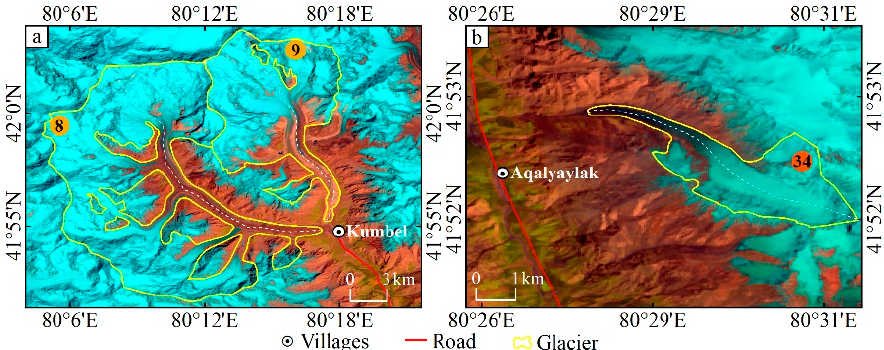
Figure 15. The surge phase ( a ), quiescent phase ( b ) and the time of surge ( c ) in different regions of High Asia ( ● ~—indicates a year greater than that (5, 42) indicated by the symbol. Data in the figure are from the literature ([11,16,21,56,84,88,89]; this study)).